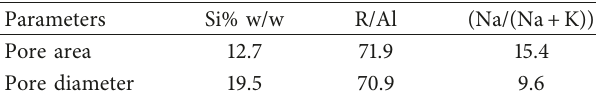
Table 5: Contribution (%) of the studied parameters to the pore area and pore diameter of the